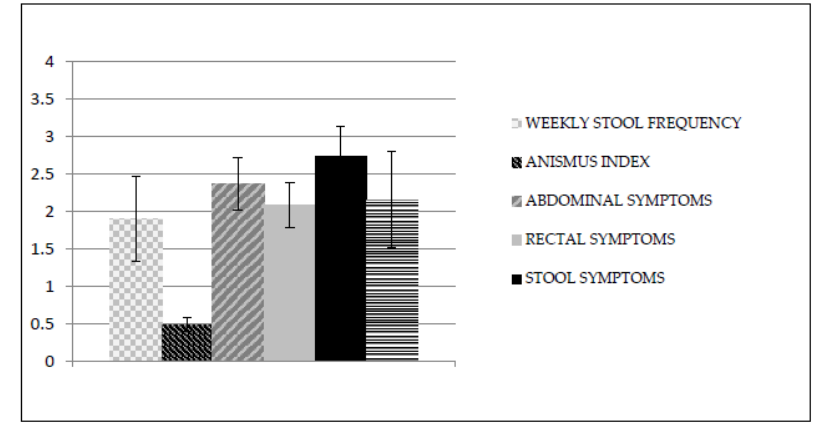
Figure 3. Mean values in all dependent measures after treatment in the control group.